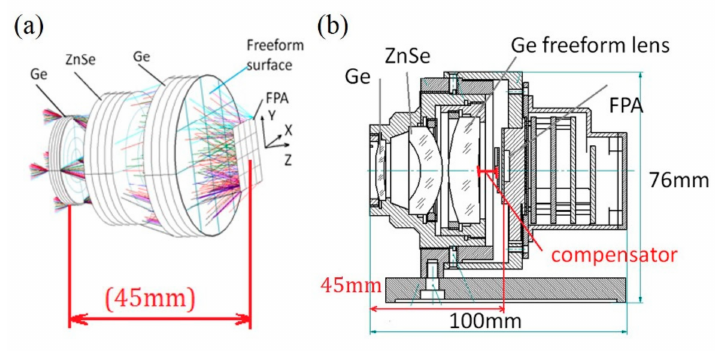
Figure 2. Configuration of the infrared (IR) thermal imager. ( a ) Three-dimensional drawing system and ( b ) structure